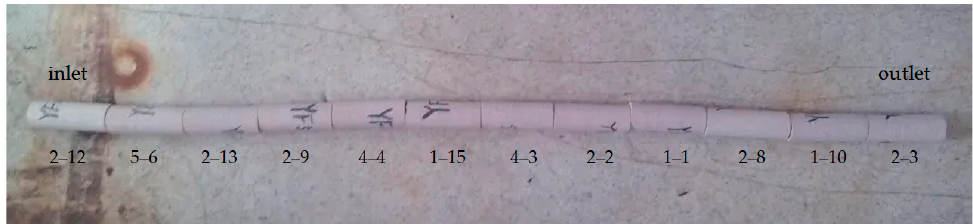
Figure 1. Long core sequence (medium permeability).